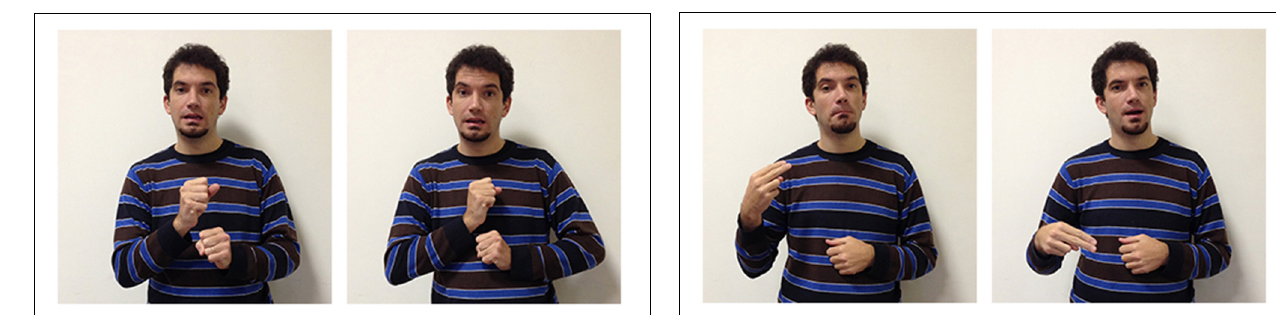
FIGURE 8 | LIS sign IMPOSSIBLE H - pa - pa